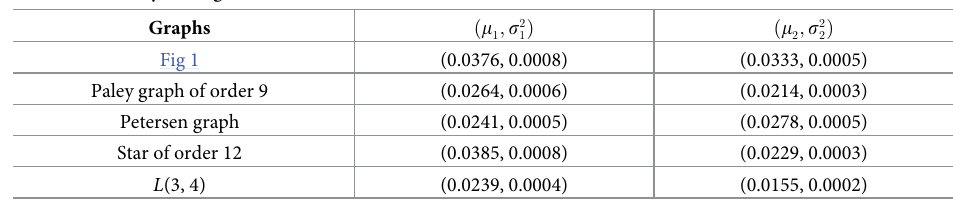
Table 1. Accuracy for Algorithms 1 and 2. Graphs